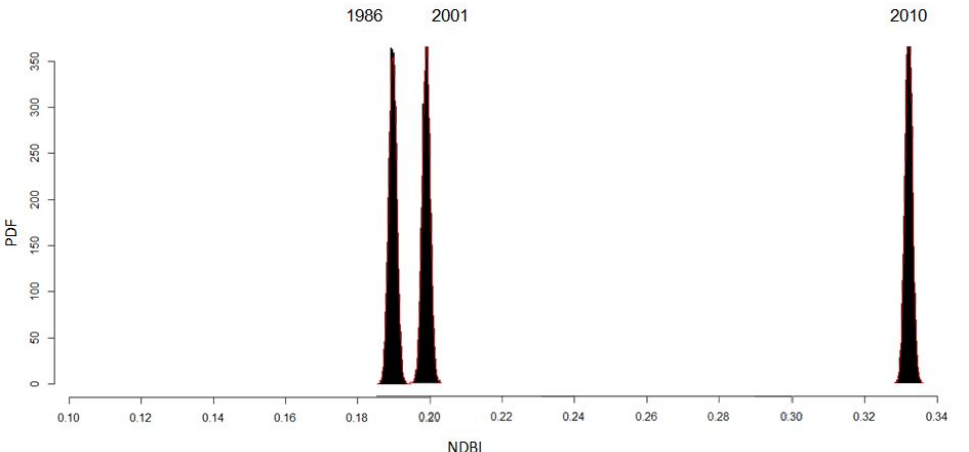
Figure 11. Probability Density Function calculated from the MCM of